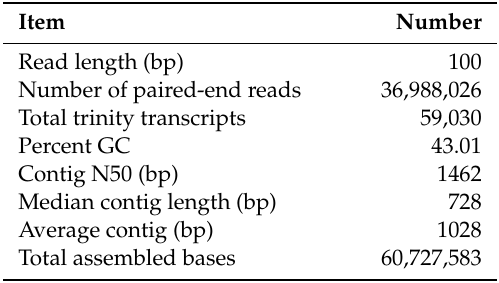
Table 2. RNA sequencing and assembly statistics of C. incanus